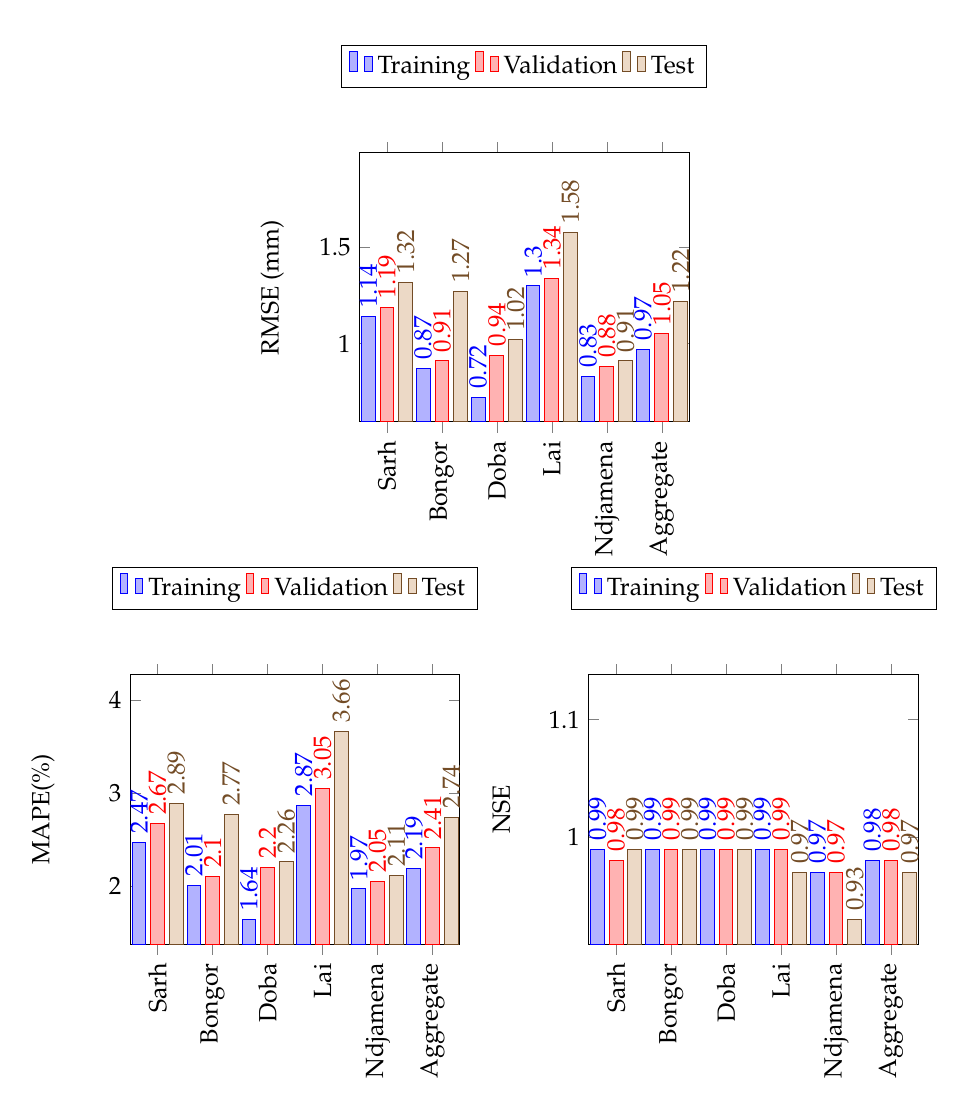
Figure 11. The LSTM model performance on the training, validation and test sets of maximum temperature in the Lake Chad Basin. The number of simulations run were 20 in all